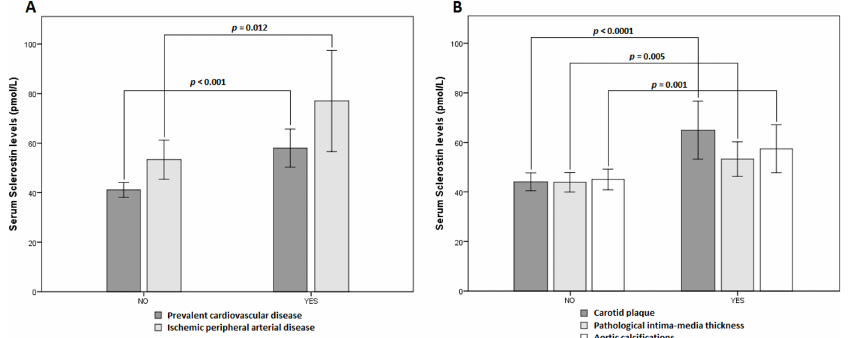
Fig 2. Serum sclerostin levels in the study participants according to the presence of cardiovascular parameters. (A) Serum sclerostin levels according to the presence of prevalent CVD in the entire cohort and according to the presence of ischemic peripheral arterial disease in the CVD group; (B) Serum sclerostin levels according to the presence of abnormal subrogated markers of CVD (carotid plaque, pIMT and aortic calcifications) in the entire cohort. Data are means ± 95% CI. Significant differences between group regions are indicated by a bar with the p -value given above. CVD: cardiovascular disease; pIMT: pathological intima media thickness; CI: confidence interval.